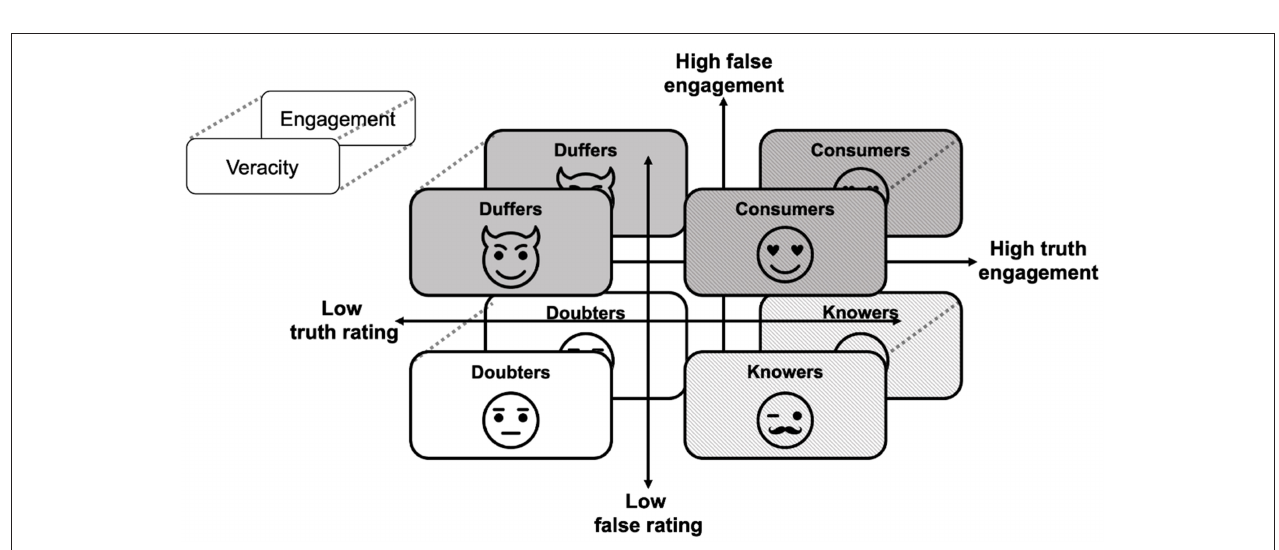
FIGURE 3 | Four phenotypes of susceptibility to (mis)information. Consumers—the people highly rating veracity of and/or engagement with any kind of information; Knowers—the people highly rating veracity of and/or engagement with true news and low rating veracity of and/or engagement with fake news; Duffers—the people highly rating veracity of and/or engagement with fake news and low rating true news; Doubters—the people rating veracity of and/or engagement with all news